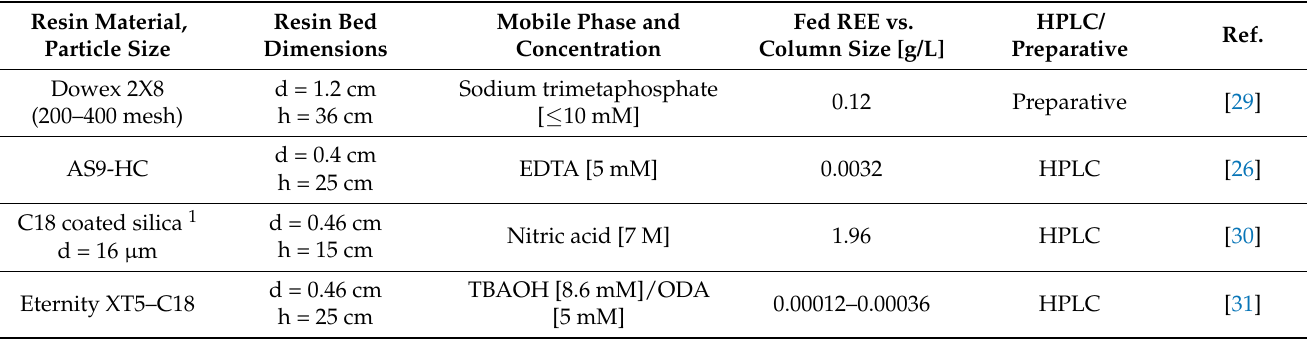
Table 1. Examples of REE separations using chromatographic